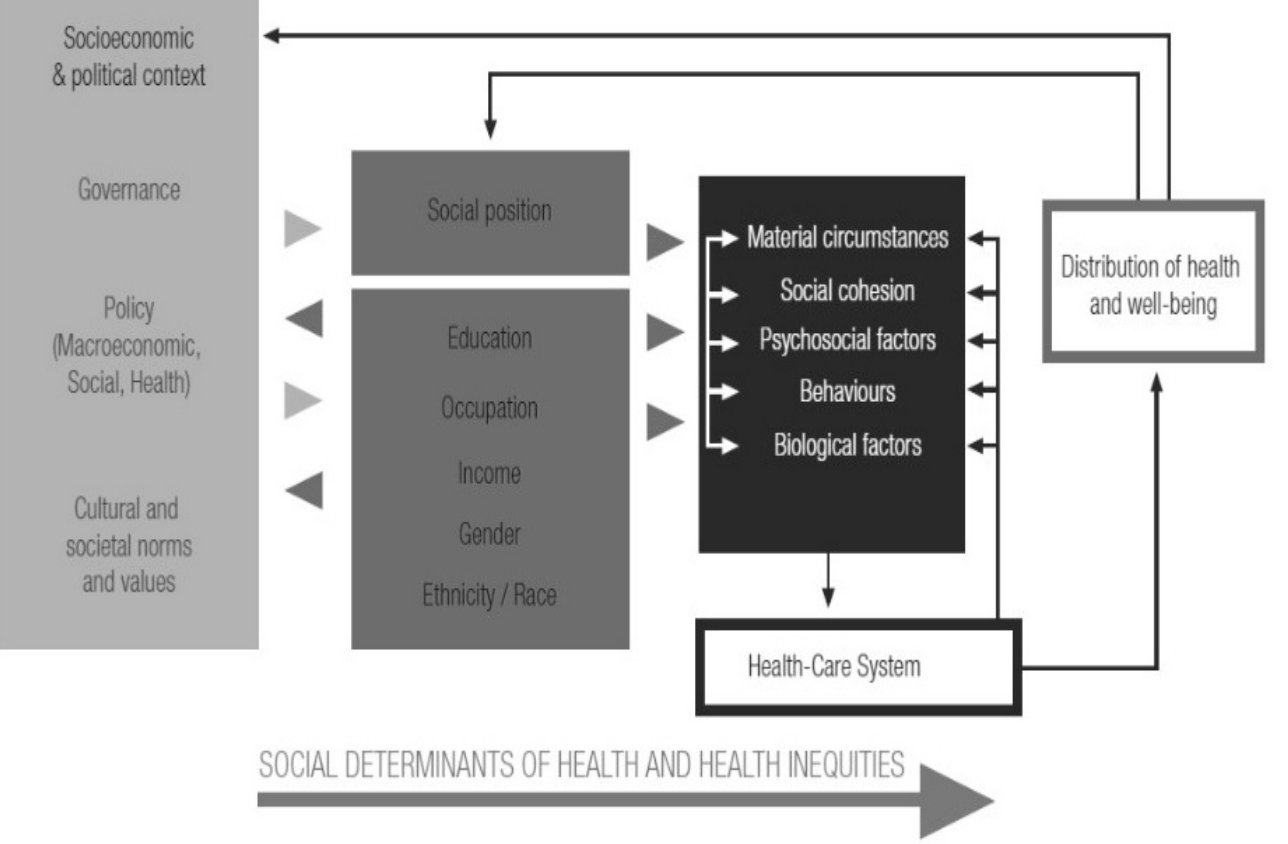
Figure 1. The World Health Organization’s (WHO) Conceptual framework for action on social determinants of health (amended from: [18]). The three columns left from the ‘Distribution of health and well-being’ box represent the three major categories of SDH, each defined through the particular determinants it lists. From left to right, the categories are: ‘Socio-political context’, ‘Structural SDH’ and (optionally including healthcare system related determinants represented by the so-named box) ‘Intermediary SDH’ (for further details, see also the original WHO source: [18]).